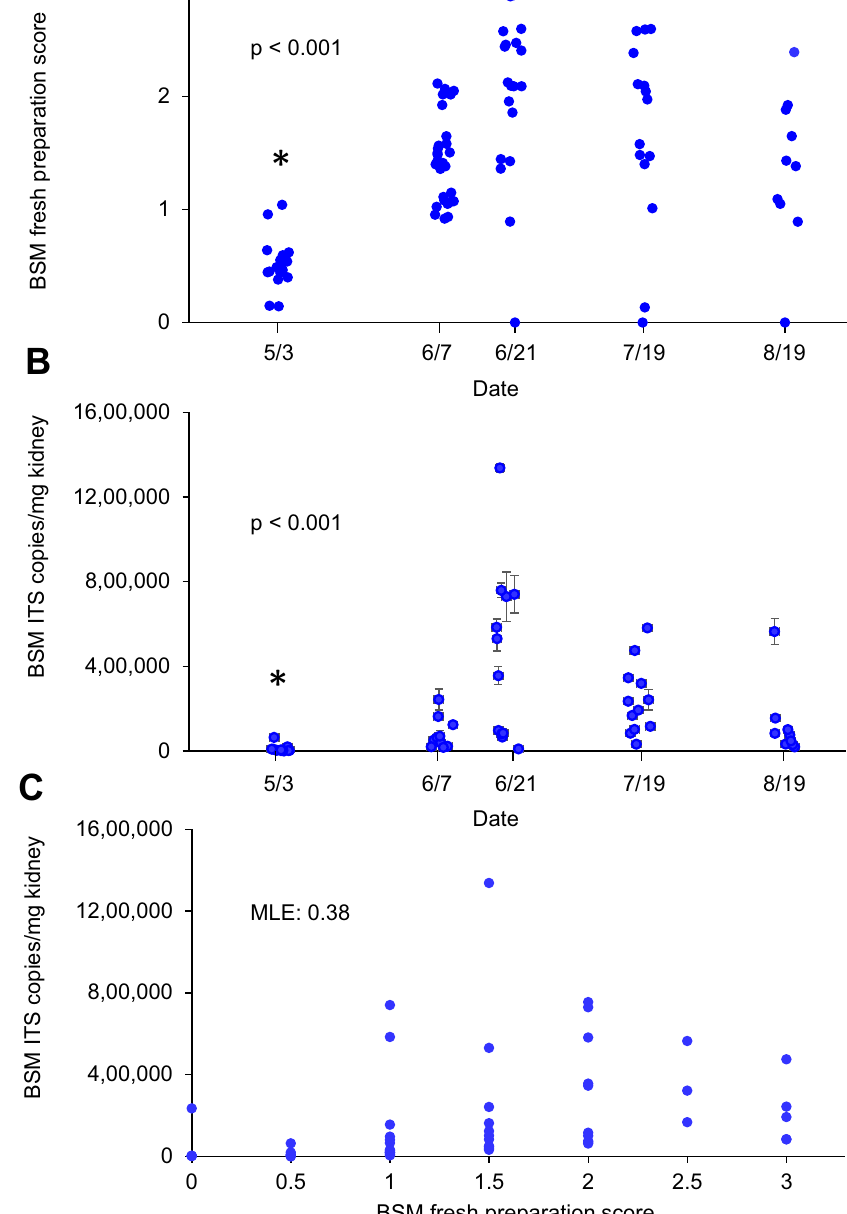
Figure 10. BSM infection intensity by fresh preparation score ( A ) and qPCR ( B ) in scallops collected from Orient Harbor between May 3 and August 19, 2021. Polyserial correlation between both detection techniques is presented in ( C ) where the Maximum Likelihood Estimator (MLE) is given. Asterisks indicate significant differences between May and all other sampling dates ( P -values are given for the ANOVA on ranks in A and parametric ANOVA on Log10 transformed values in